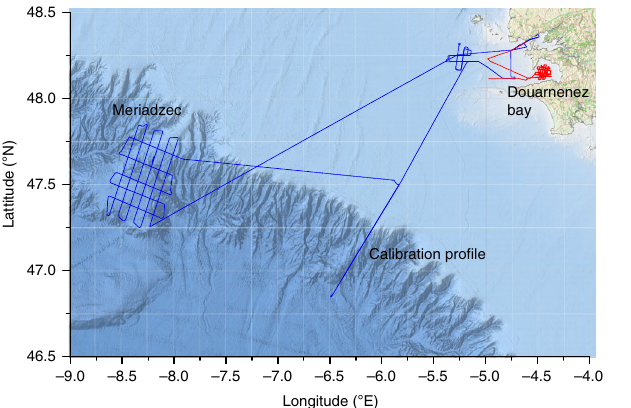
Fig. 3 Map of the location of the gravity survey. Blue line: course of the ship during October 2015 survey. Red line: course of the ship during January 2016 survey. The background map is from EMODnet Bathymetry Consortium (2016): EMODnet Digital Bathymetry (DTM).